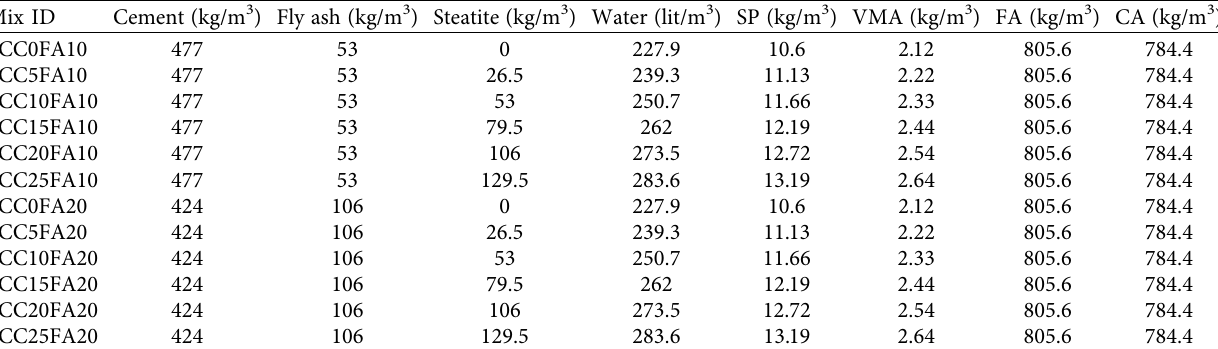
Table 2: Mix proportions developed to achieve